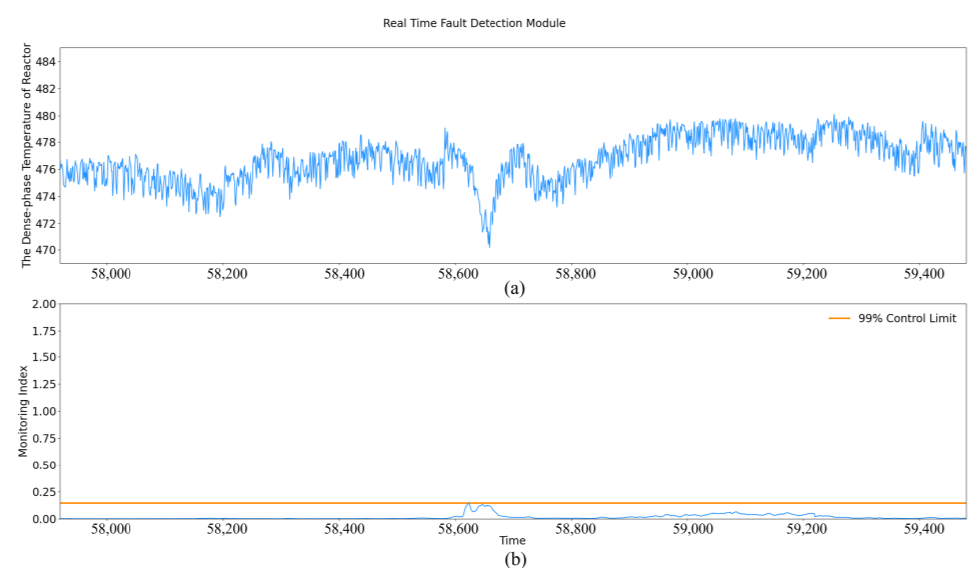
Figure 12. Process monitoring result on case one obtained by the model using Euclidean distance- based data labeling strategy: ( a ) Original data of the key variable; ( b ) Fault detection results.